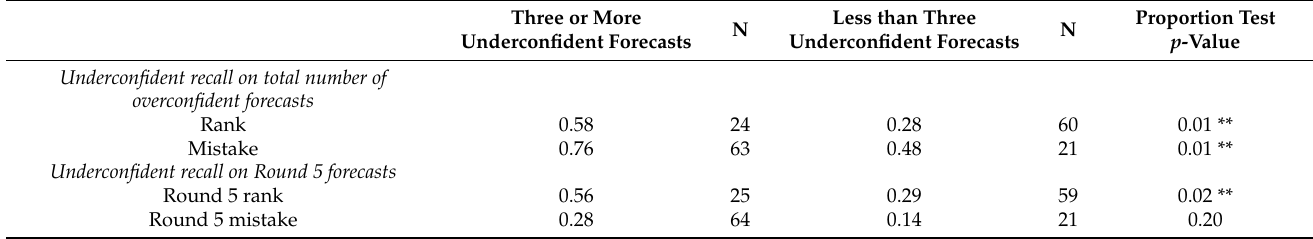
Table 5. Comparison of Underconfident Recall Conditional on Underconfidence in